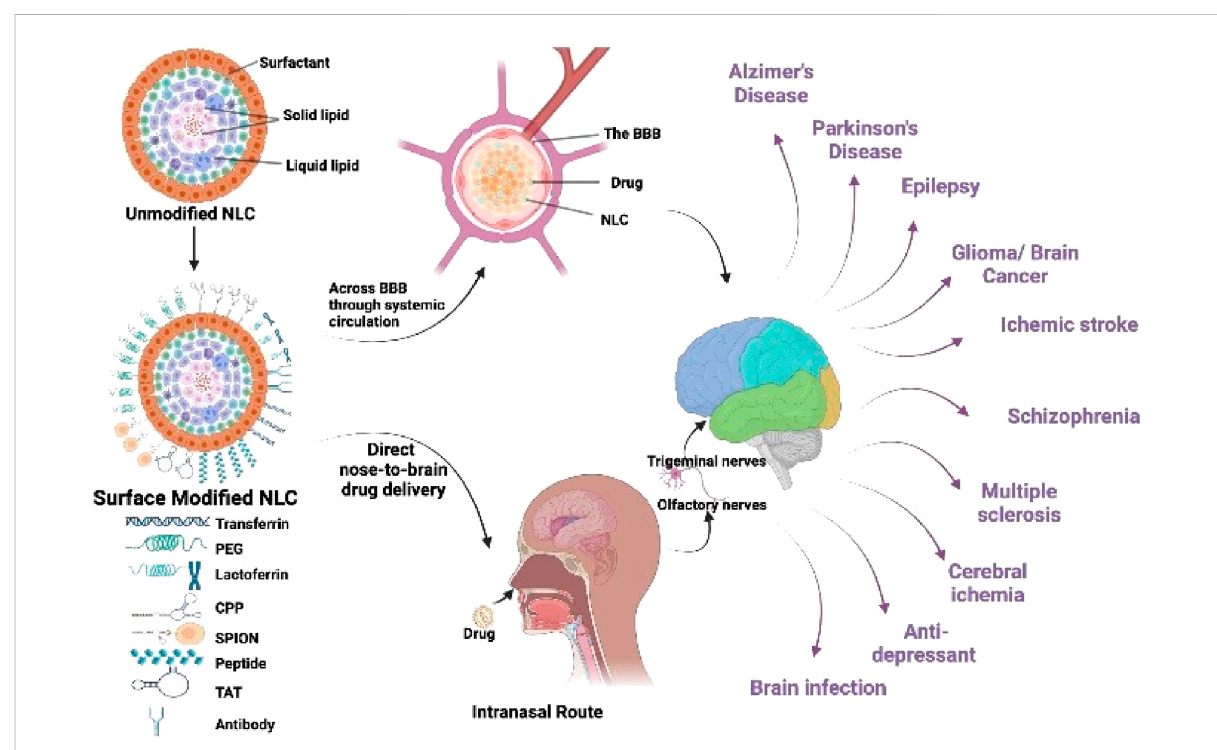
FIGURE 4 Strategies and advancements in the fabrication of nano lipid carriers for brain